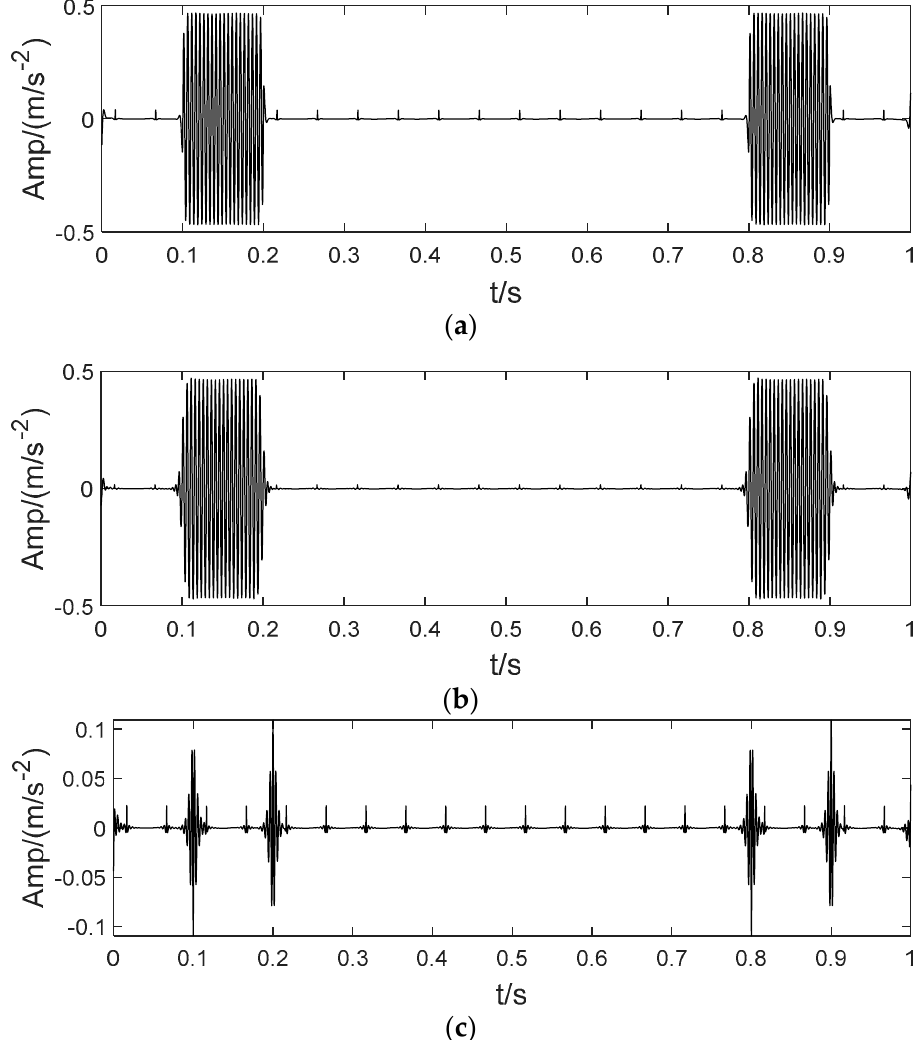
Figure 9. The third decomposition result. ( a ) IMF21, ( b ) IMF211 and ( c ) IMF212.